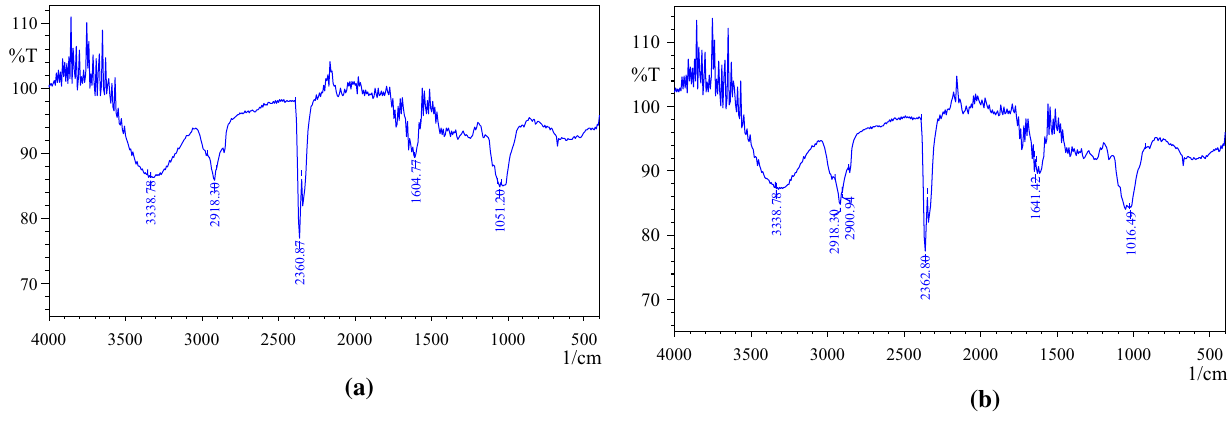
Fig. 2 a FTIR of mosambi peel dust before Cr(VI) adsorption b FTIR of mosambi peel dust after Cr(VI)